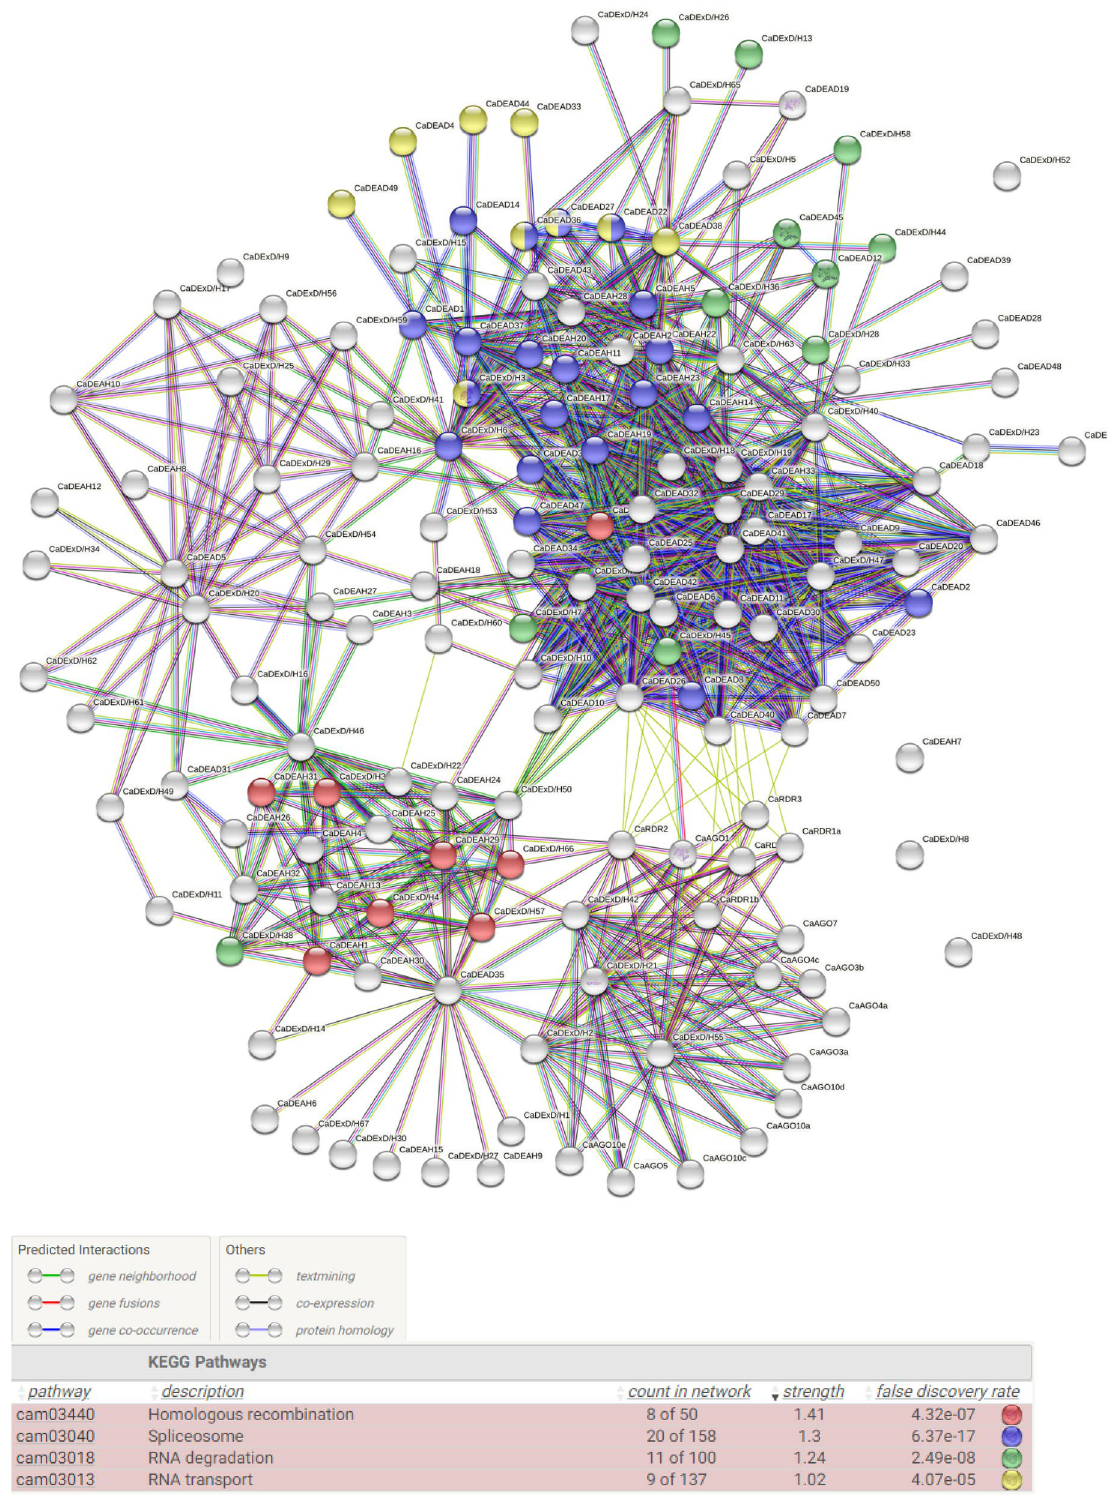
Figure 6. The protein–protein interaction networks for the chickpea RNA helicases (CaDEAD, CaDEAH and CaDExD/H - box proteins) and sRNA associated proteins (CaAGO and CaRDR). The experimentally validated interactions, as reported in previous published papers, are represented with pink edges. The filled nodes depict the proteins with known 3D structures. Colour of the nodes represent the KEGG pathway GO terms (www. kegg. jp/ kegg/ kegg1.